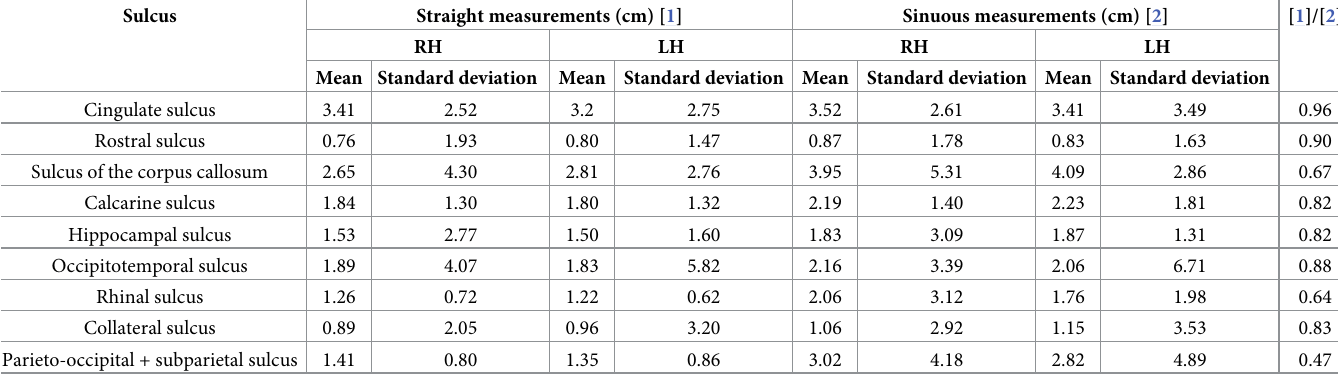
Table 5. Straight and sinuous measurements of the sulci on the medial aspect of the brain in Sapajus libidinosus . Sulcus